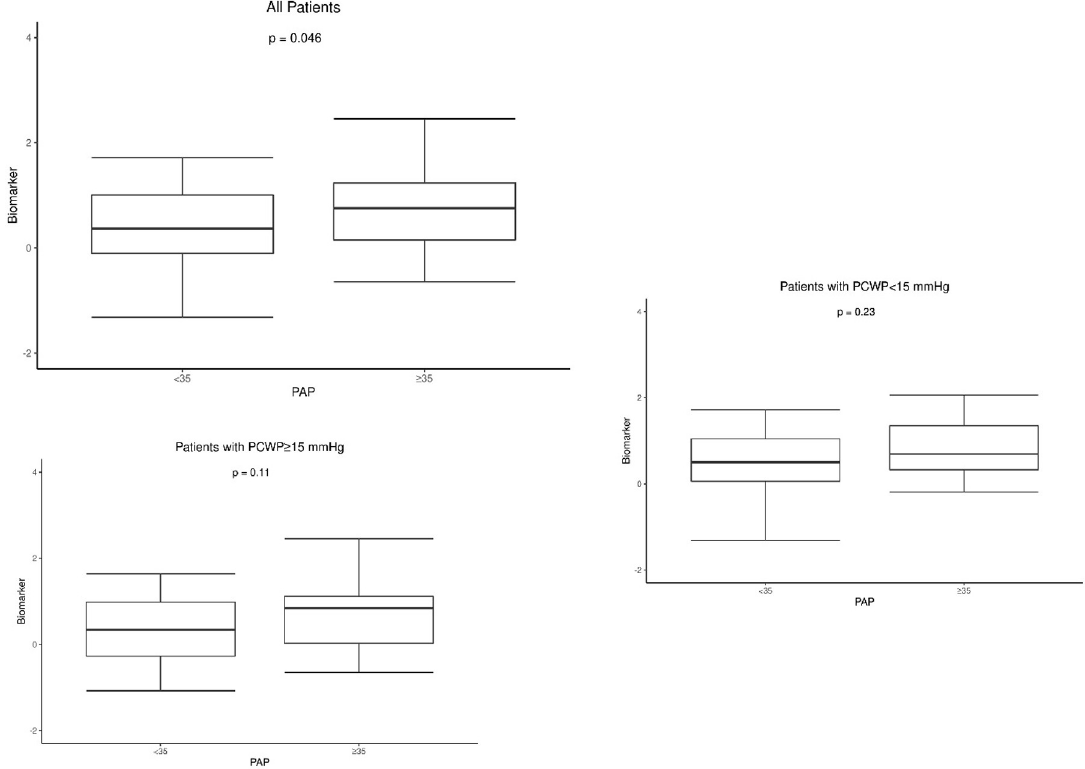
Fig 1. Boxplots comparing values of the voice biomarker between individuals with a high ( � 35 mmHg) versus lower pulmonary arterial pressure. A: In all patients; B: In patients with a PCWP � 15 mmHg; C: In patients with a PCWP < 15 mmHg. Abbreviations: PAP–Pulmonary arterial pressure; PWPW–Pulmonary capillary wedge pressure. � statistically significant difference between groups.